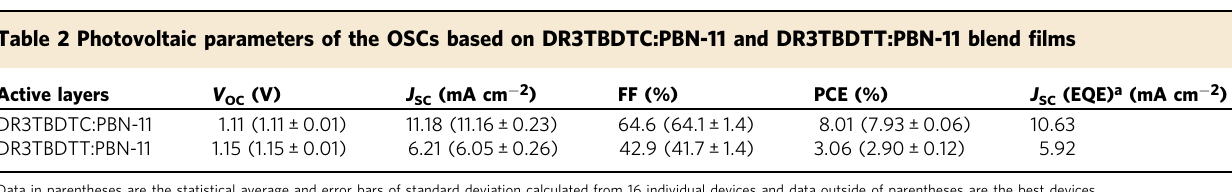
0.0 Fig. 3 Photovoltaic performance of the OSCs. a J – V plots of the OSC devices based on DR3TBDTC:PBN-11 and DR3TBDTT:PBN-11 blends under the illumination of AM1.5 G, 100 mWcm − 2 . b EQE spectra of the corresponding OSC devices